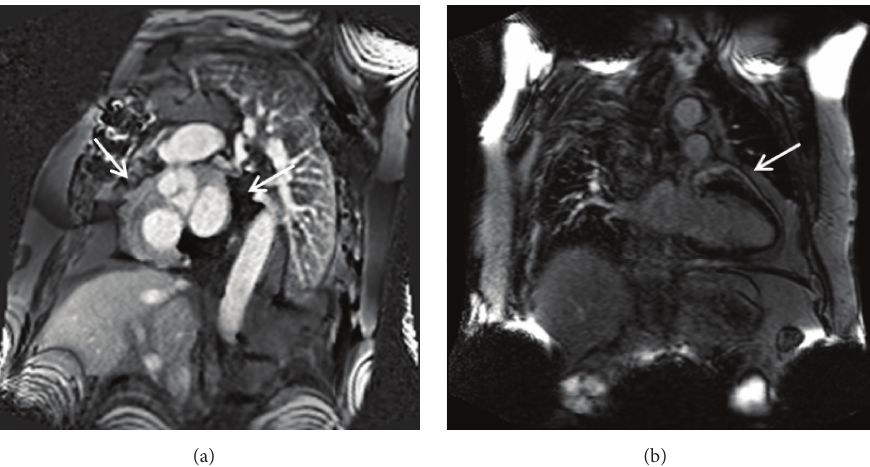
Figure 3: Cardiac granulomatosis with polyangiitis in a 57-year-old man. Phase sensitive inversion recovery images in the short axis (a) and long axis projections (b), 1 minute after the intravenous administration of contrast material show enhancing soft tissue thickening around coronary arteries (a) and pericardium (b).